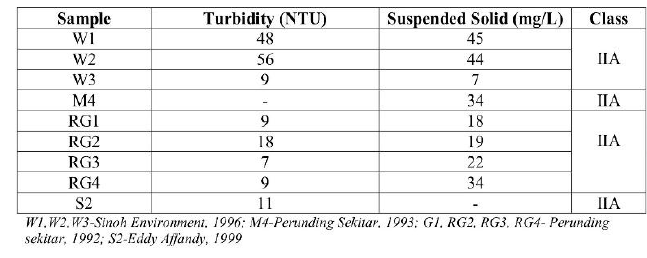
Table 4 : The water quality and class.